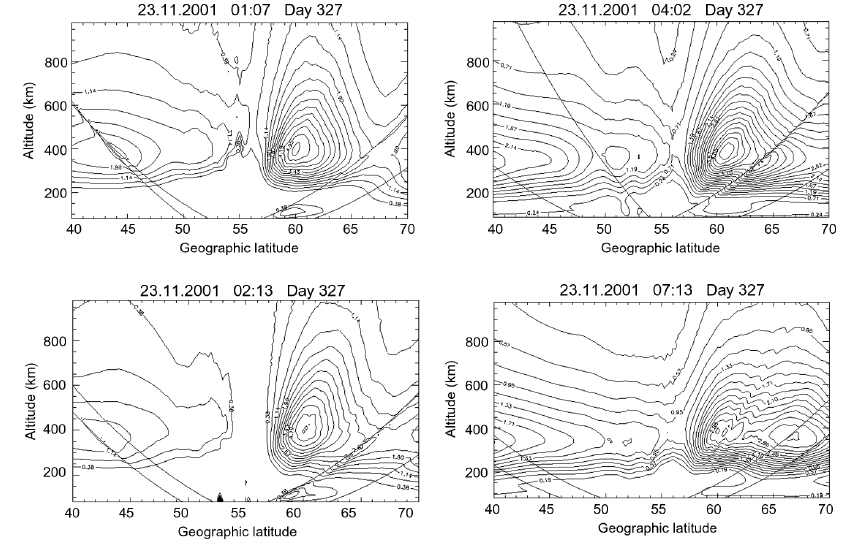
Fig. 9. A sequence of tomographic images from four satellite passes throughout the night of 326-327, moni- tored at the stations in U.K., which show a deep trough with a strong ionisation enhancement or boundary blob polewards of the minimum that is acting as a reflector for the out-of-great-circle HF propagation found on the Uppsala to Leicester path shown in fig.